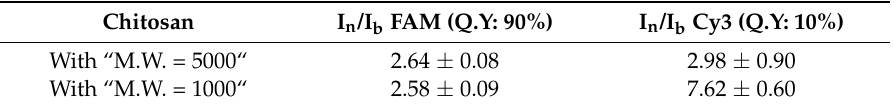
Table 1. Fluorescence measurement for both 1000 and 5000 Da chitosan-coated Au nanostructures using FAM and Cy3